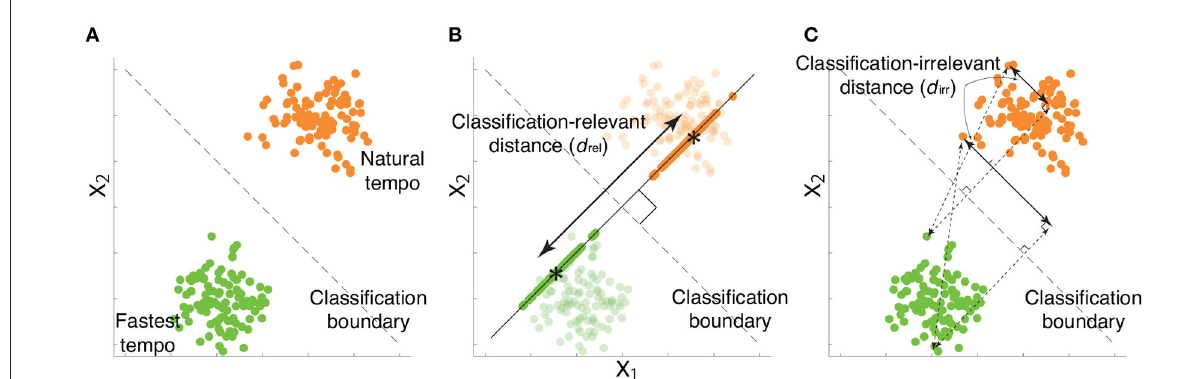
FIGURE4 Examples of classification-relevant distance d rel and classification-irrelevant distance d irr based on simulated data. (A) Two-dimensional simulated data when considering a desired classification boundary (the black dotted line). Green and orange dots indicate simulated data from a single trial associated with the fastest and natural tempi, respectively. (B) Classification-relevant distance in the simulated data. The classification-relevant distance is based on the distance along the orthogonal direction to the classification boundary. Green and orange dots on the line orthogonal to the decision boundary indicate classification-relevant components. Asterisks within green and orange dots denote the averages of classification-relevant components associated with fastest and natural tempo, respectively. For example, if the distance between two groups of data along the direction is zero, classifying the data into fastest and natural tempi is impossible. (C) Classification-irrelevant distance in the simulated data. In the case of two-dimensional data, classification-irrelevant distance is based on the distance along the direction parallel to the classification boundary. If we observe two groups of data whose means are on the classification boundary but have different values, it is impossible to classify the data as reflecting either the fastest and natural tempi. Although the classification-relevant distance is zero in this case, the task-irrelevant distance along the classification boundary is not